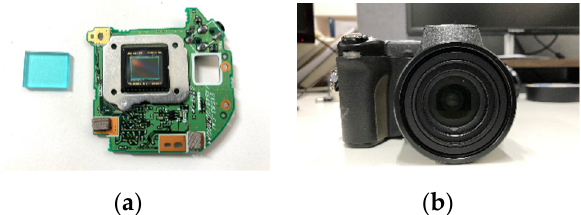
Figure 5. Imaging system used in the experiment. ( a ) The IR cut filter and imaging detector in the camera, ( b ) the camera used in the experiment. camera, ( b ) the camera used in the